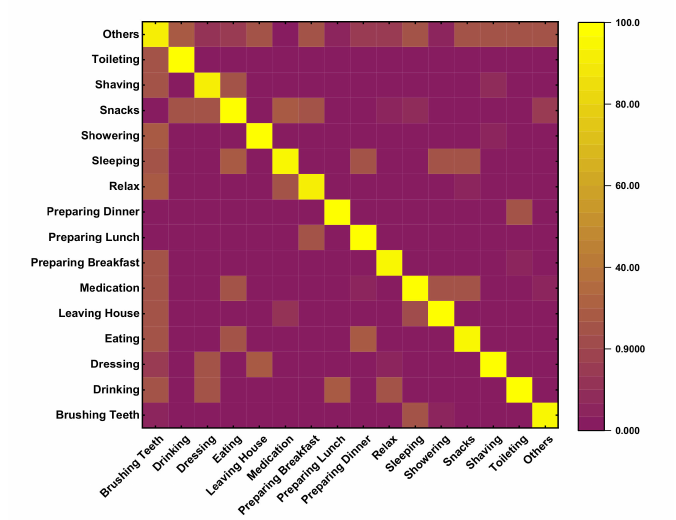
Figure 12. Confusion matrix for Kasteren-House-B.